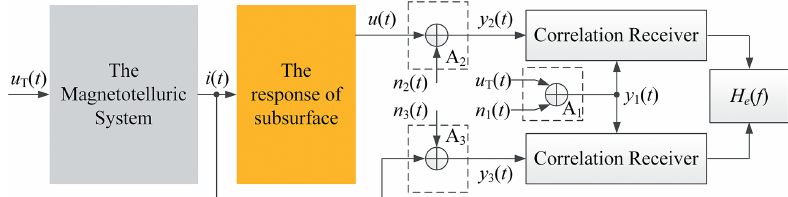
Figure 3. The schematic diagram of the ECI denoising model.